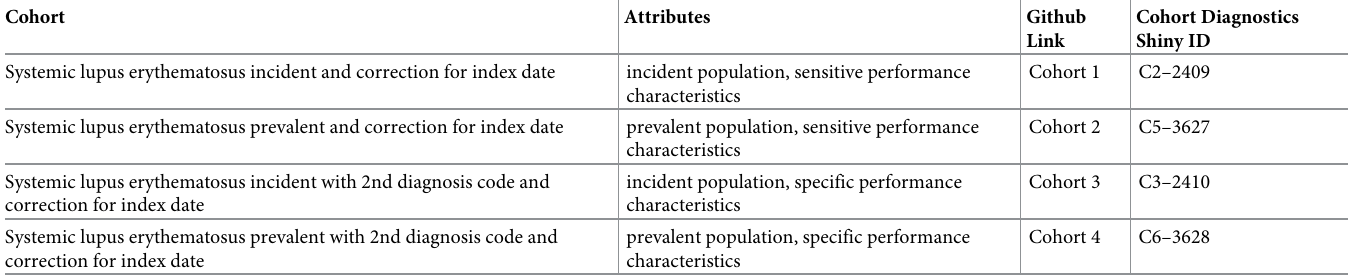
Cohort Diagnostics Link Shiny ID characteristics characteristics